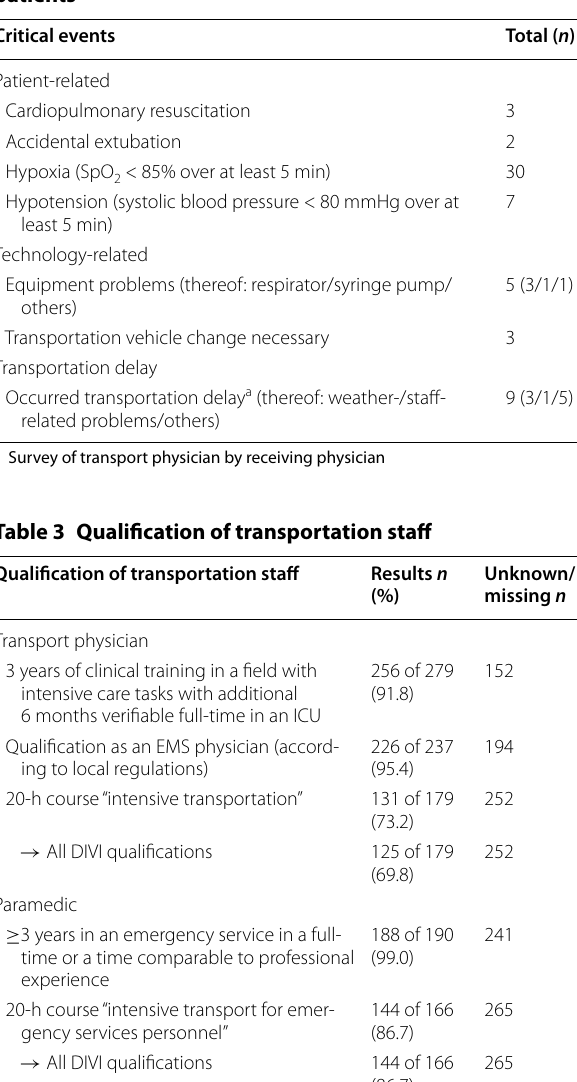
Table 2 Frequency of critical events in 431 observed